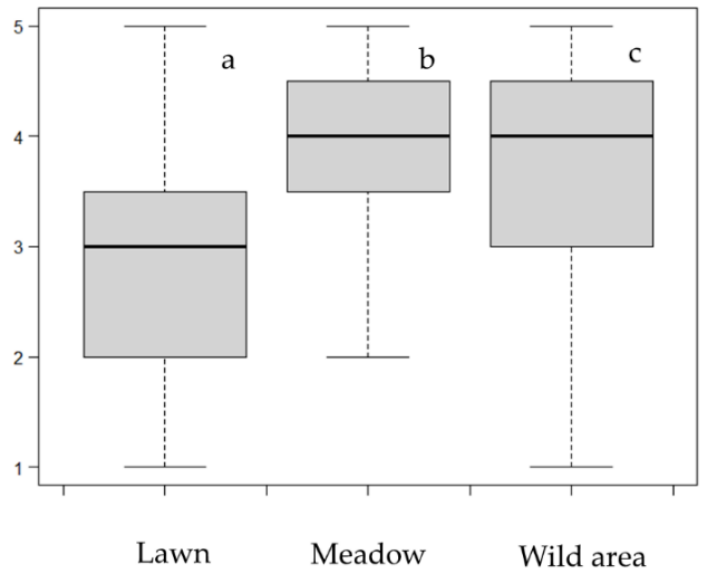
Figure 5. Preference ratings for lawn, meadow, and wild area with ratings of paired photo stimuli (with and without the dead tree) combined ( n = 627). Different letters indicate significant differences at the p < 0.001 level. Scale of 1 (‘do not like at all’) to 5 (‘like very much’).